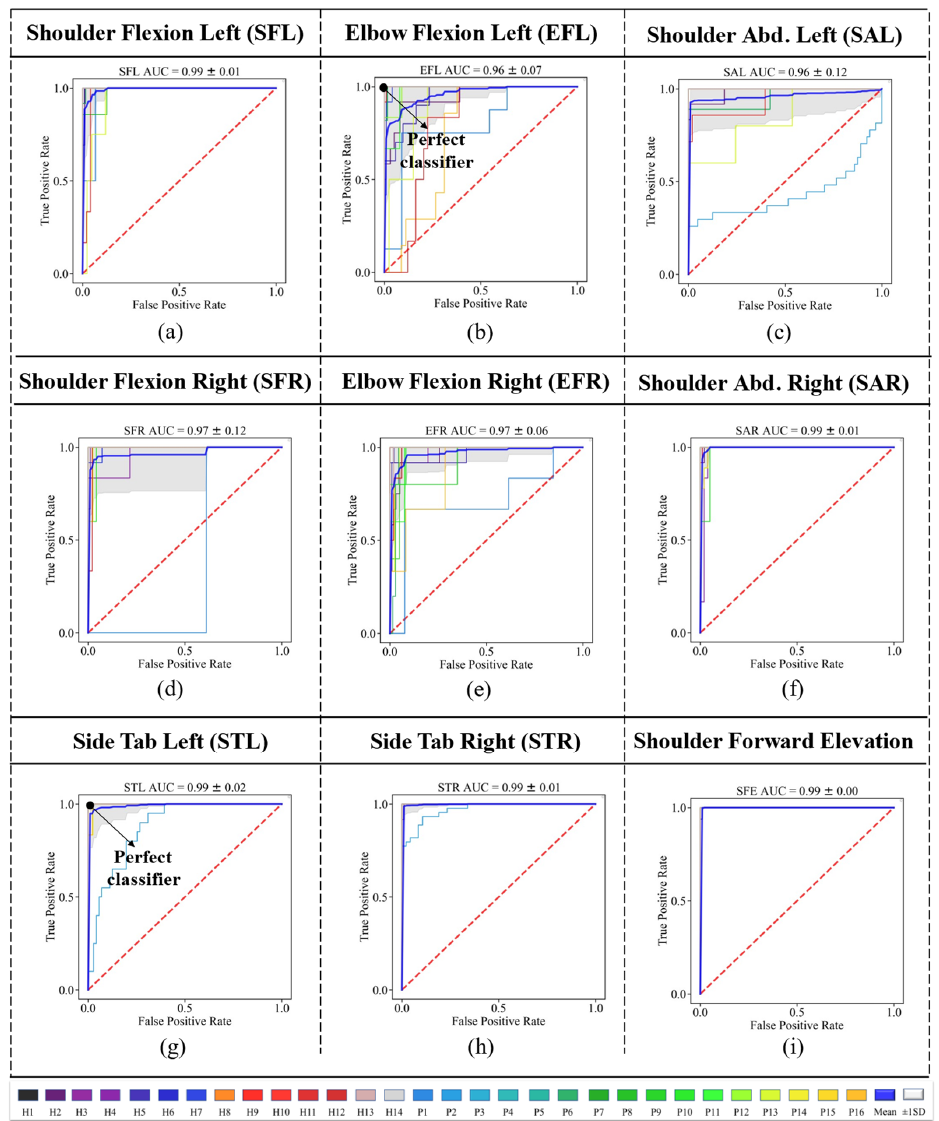
Figure 8. ROC curves for all subjects for gestures ( a ) SFL, ( b ) EFL, ( c ) SAL, ( d ) SFR, ( e ) EFR, ( f ) SAR, ( g ) STL, ( h ) STR, and ( i ) SFE. The mean curve is drawn in blue.